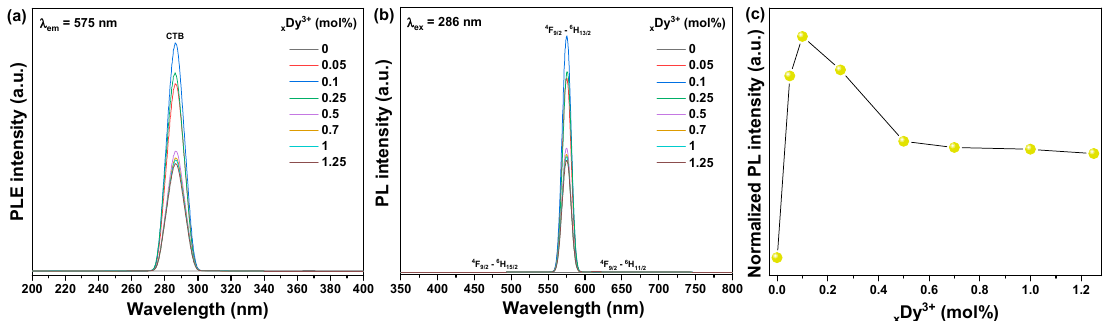
Figure 6. Luminescence properties of MnWO 4 :Dy 3+ : ( a ) PLE spectra under 575 nm, ( b ) PL spectra under 286 nm, and ( c ) integrated PL intensity.